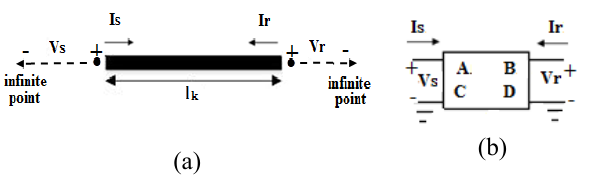
Figure 3: (a): Definition of sending and receiving voltage and current for a conductor of length and (b): Two-port network representation of a conductor of length .